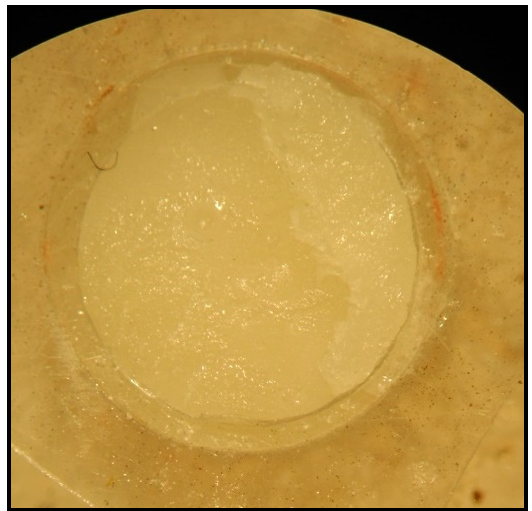
Figure 6. The specimen shows a mixed type of bond failure.